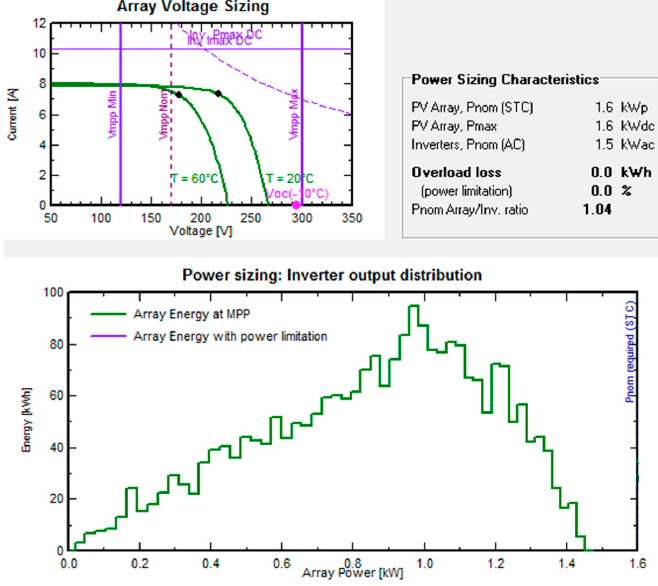
Figure 6. Prototype response curves (voltage and power sizing).